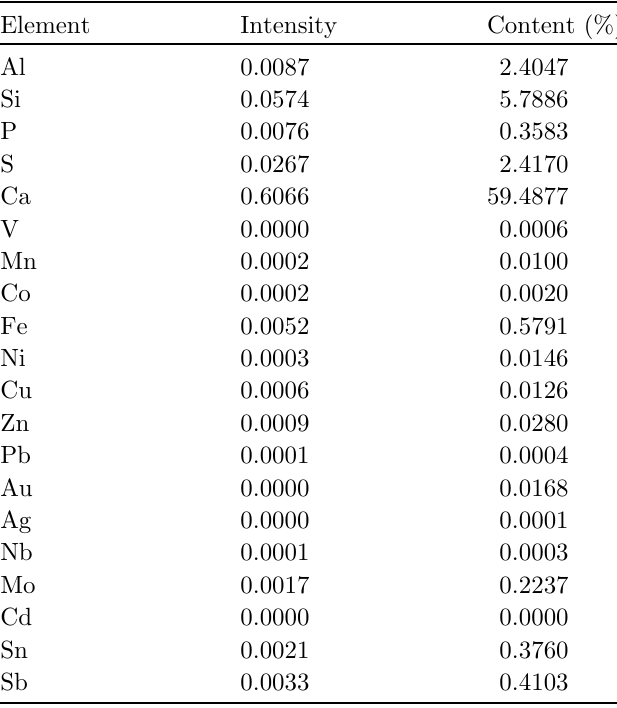
Table 1. XRF result for PU foam with